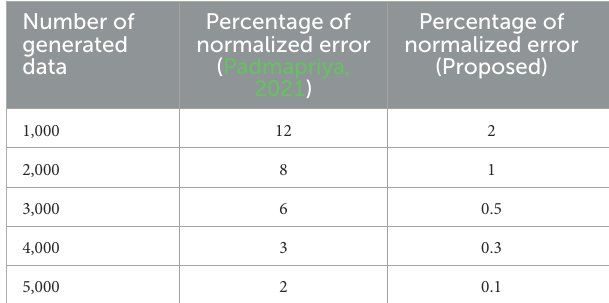
TABLE 6 Comparison of normalized